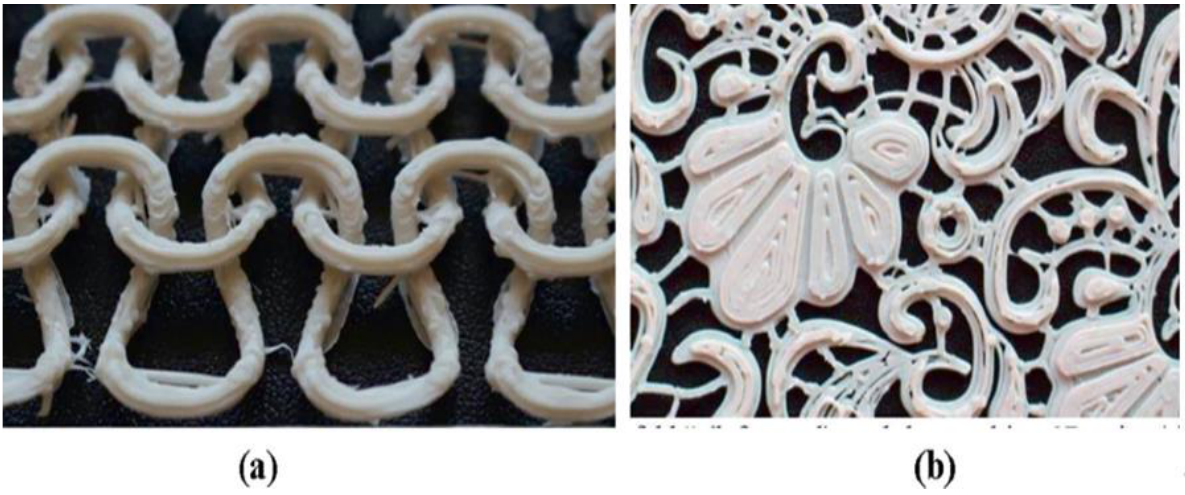
Figure 19. ( a ) 3D-printed weft knit and ( b ) lace structure in textile industry. Adapted with permission from Chakraborty et al. [212]. 2020, Elsevier.